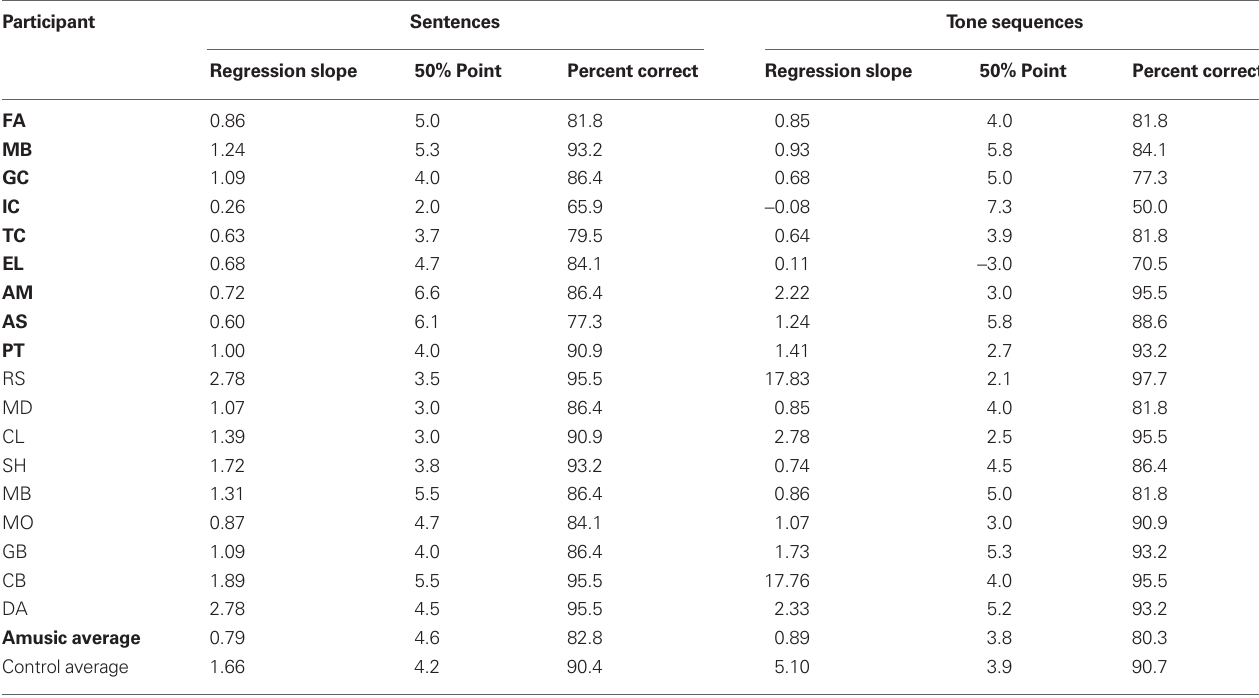
Amusic participants are in bold. Regression slope indicates the slope of the logistic regression computed from the individual participant’s data. Note that regression slopes increase exponentially, thus controls RS and CB do not represent behavioral outliers. The 50% Point indicates the point at which the logistic regression rises to 0.5, taken as the cutoff between statement and question, or rising and falling. Percent correct indicates the percent of each participant’s answers scored correct, when judged using their own 50% as the cutoff. Averages are computed from the individual